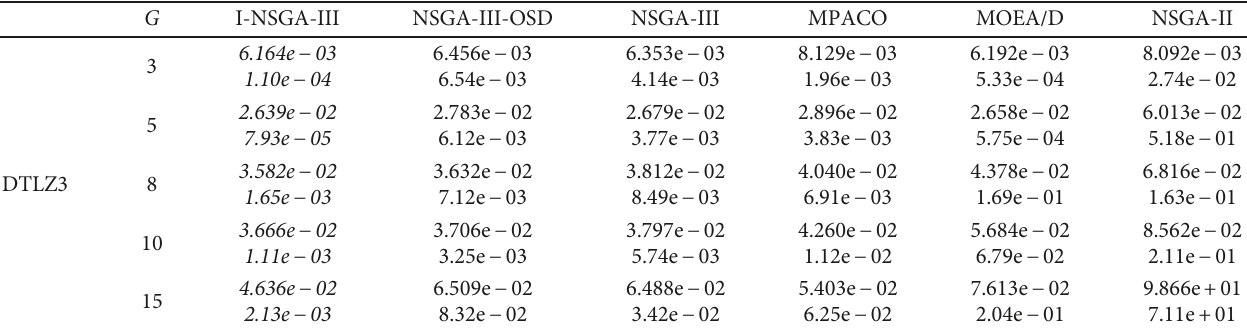
Table 11: Median and standard deviation of the IGD values achieved by each algorithm on DTLZ3 (the best medians are in italic font). G